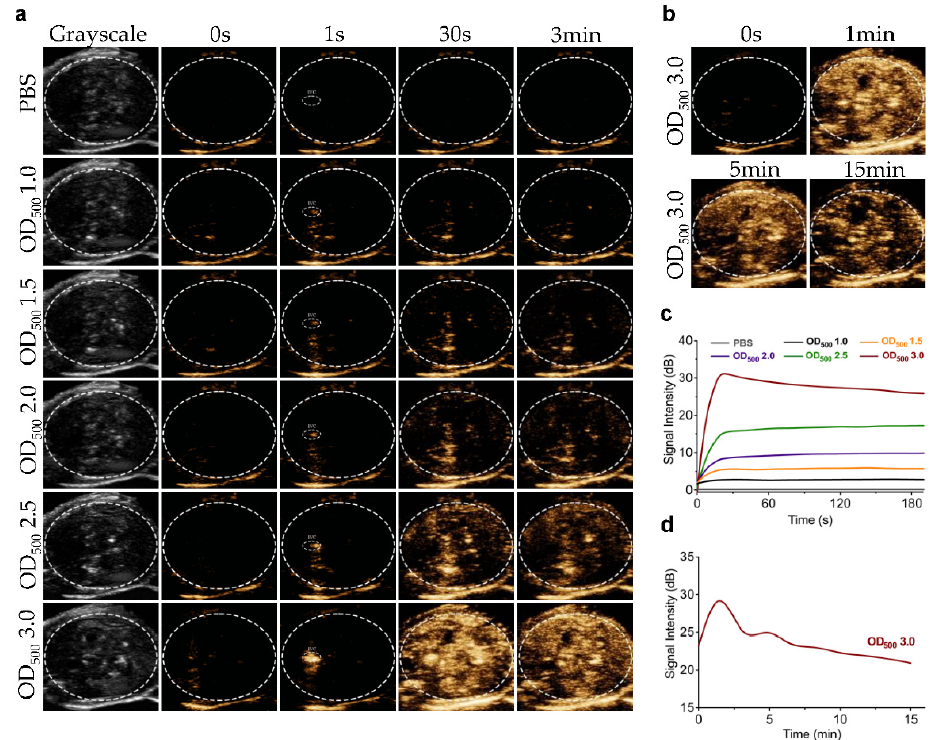
Figure 3. Ultrasound contrast imaging of GVs in vivo: ( a ) nonlinear contrast images of GVs (OD 500 1.0–3.0) at different time points after tail injection; ( b ) nonlinear contrast images of GVs at OD 500 3.0; ( c ) time–intensity curves of GVs at different concentrations in liver within 3 min; ( d ) time–intensity curves of GVs at OD 500 3.0 in liver within 15 min.